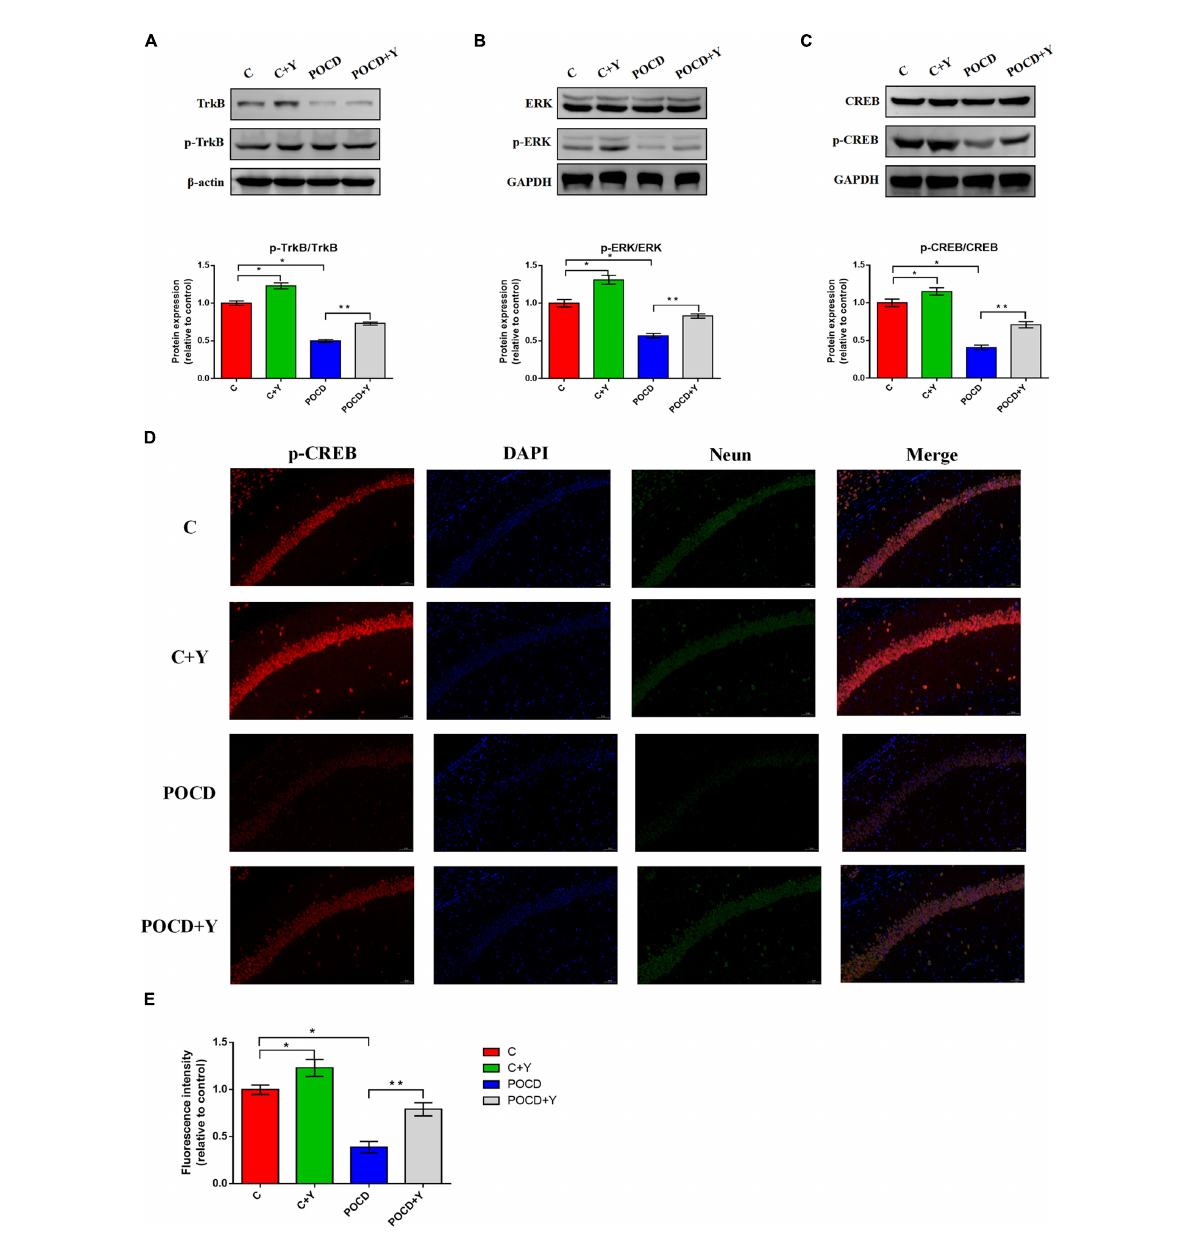
FIGURE8 Young plasma activated the tyrosine kinase B/extracellular signal-regulated protein kinase/cyclic adenosine monophosphate response element-binding protein (TrkB/ERK/CREB) signaling pathway to exert a neuroprotective effect in postoperative cognitive dysfunction (POCD) rats. The expression of proteins related to the TrkB/ERK/CREB signaling pathway including phosphorylated TrkB/TrkB (A) , phosphorylated ERK/ERK (B), and phosphorylated CREB (pCREB)/CREB (C) . (D) Representative immunostaining showing the colocalization of Neun (green), p-CREB (red), and DAPI (blue) in the CA1 of the hippocampus. Scale bar: 200 µ m. (E) Bar graph summarizing the fluorescence intensity of p-CREB in the hippocampal CA1. Data are shown as means ± standard deviations. * p < 0.05 compared with group C, ** p < 0.05 compared with group POCD ( n = 7 per